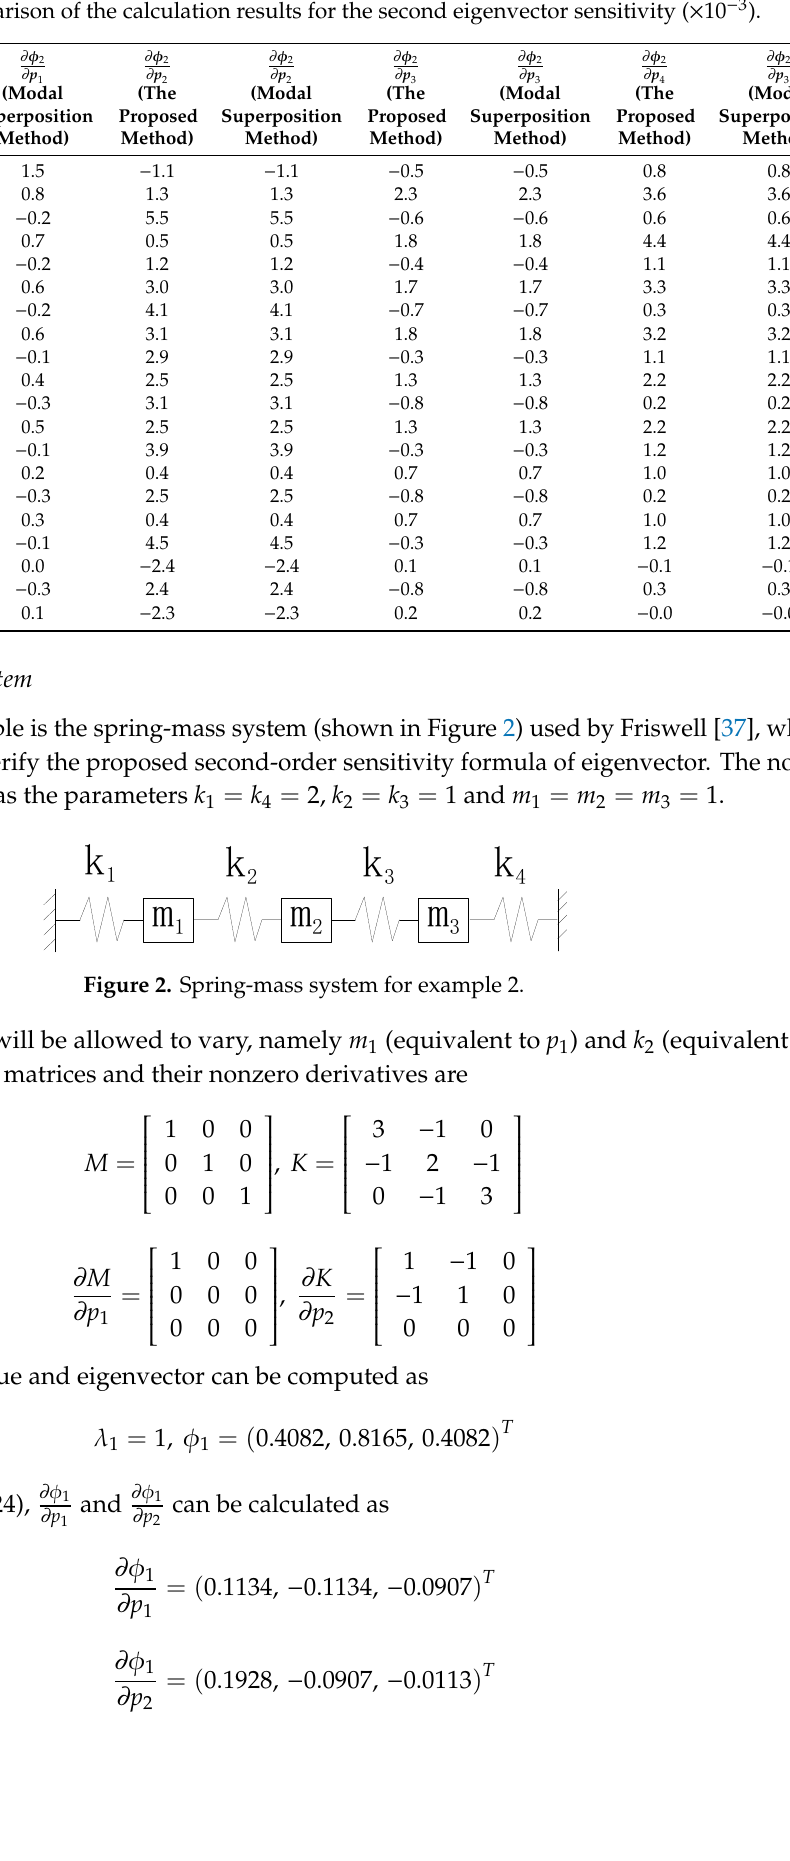
Table 2. Comparison of the calculation results for the second eigenvector sensitivity (×10 − 3 ).